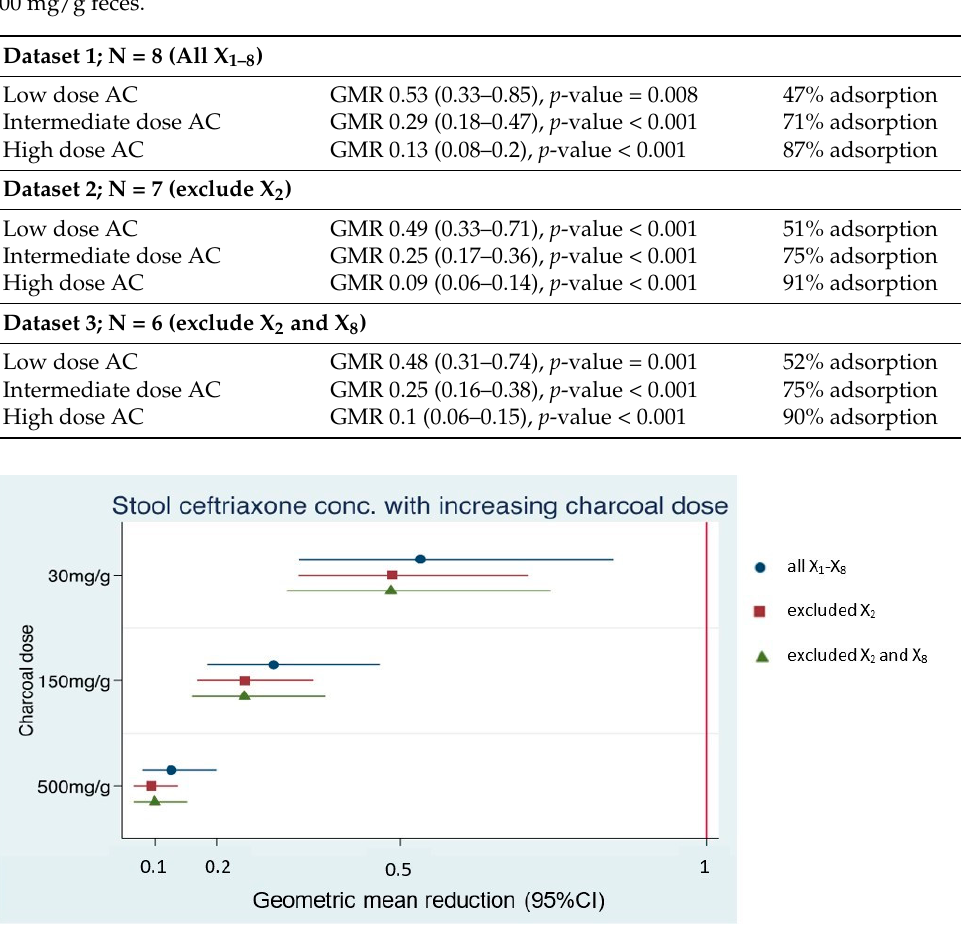
Figure 4. Geometric mean reductions in fecal ceftriaxone concentrations adsorbed by activated charcoal at different doses (low dose 30 mg/g feces, intermediate dose 150 mg/g feces, and high dose 500 mg/g feces) relative to baseline, demonstrated in three datasets: all X 1–8 (N = 8), excluded X 2 (N = 7), and excluded X 2 and X 8 (N = 6) .